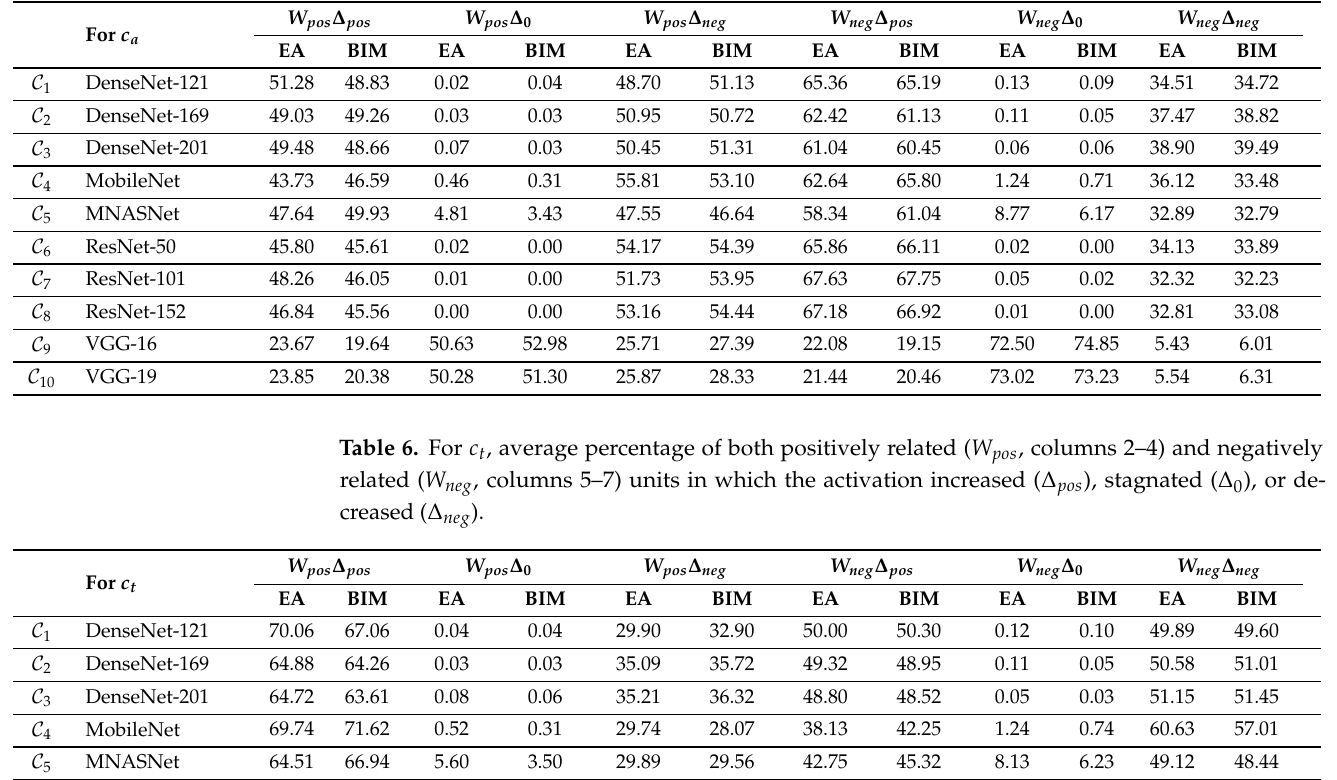
c a and Table 6 for c t (see Tables A2 and A3 in Appendix B.3 for an individual outcome)—in which the activation increased, stagnated, or decreased. For c a and c t , Table 7 presents the average change in penultimate layer activation for both the positively and negatively related units. Table 5. For c a , average percentage of both positively related ( W pos , columns 2–4) and negatively related ( W neg , columns 5–7) units, in which the activation increased ( ∆ pos ), stagnated ( ∆ 0 ), or de- creased ( ∆ neg ).